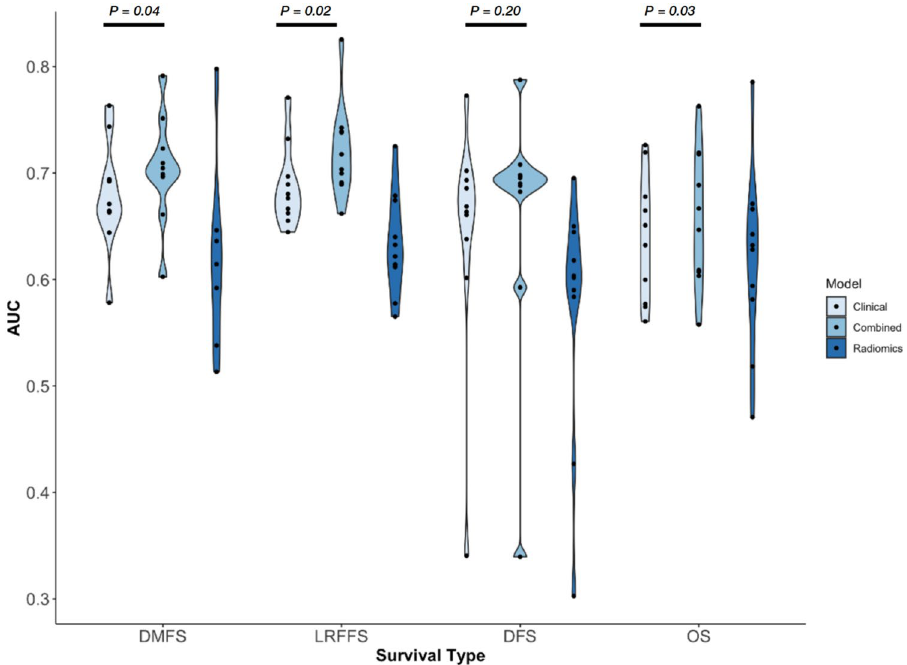
Figure 6. The violin plot of the time-dependent AUCs obtained for radiomics, clinical and combined models for the 4 types of survival. The P values are shown on top between the clinical and combined models. DMFS, LRFFS and OS show statistically significant difference between the combined and clinical